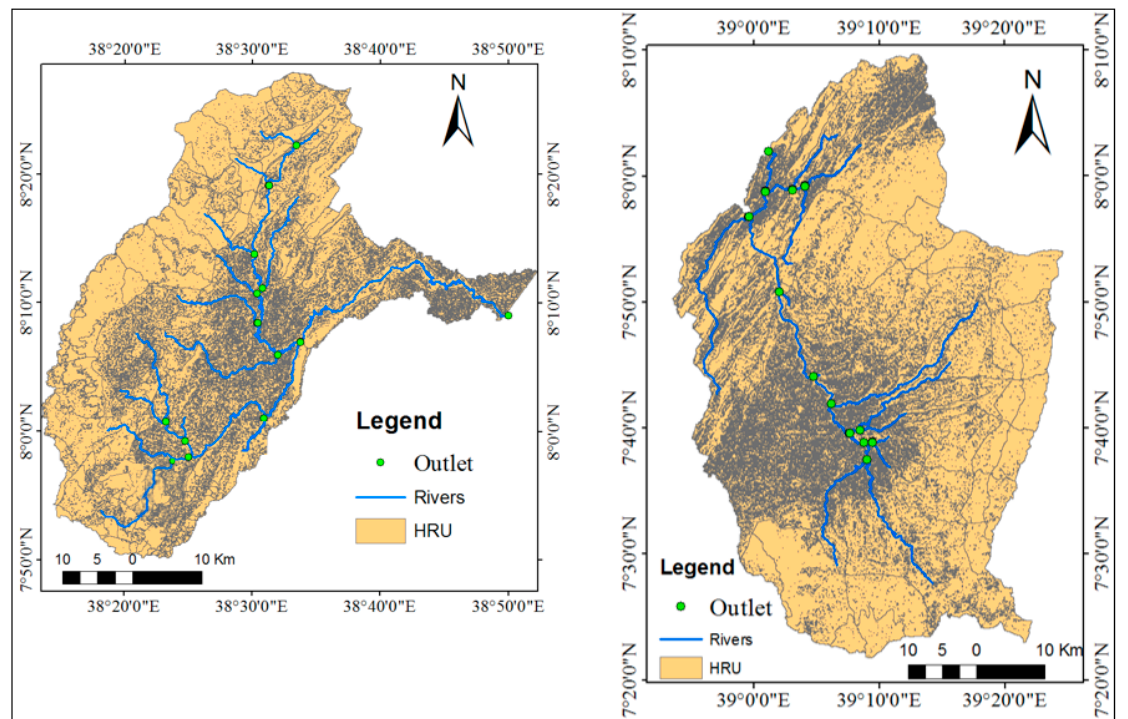
Figure 3. Hydrologic response unit (HRU): Maki ( Left ) and Katar ( Right ) Sub-watersheds.